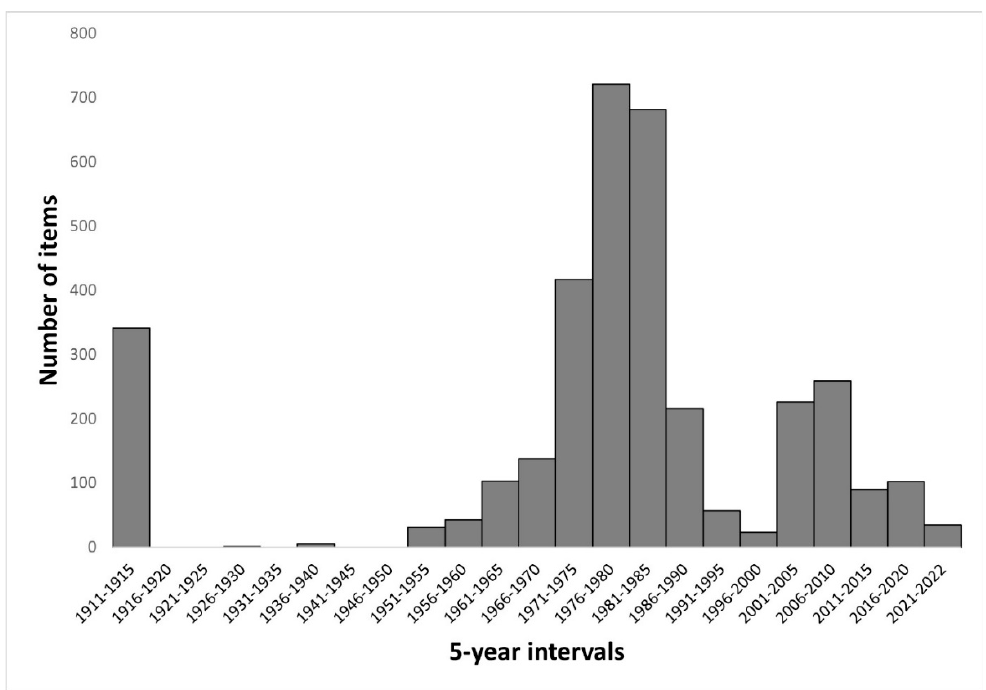
Figure 5. A clue to research efforts: number of items (i.e., reporting of a taxon, in a given site, by a given reference) per 5-year interval.